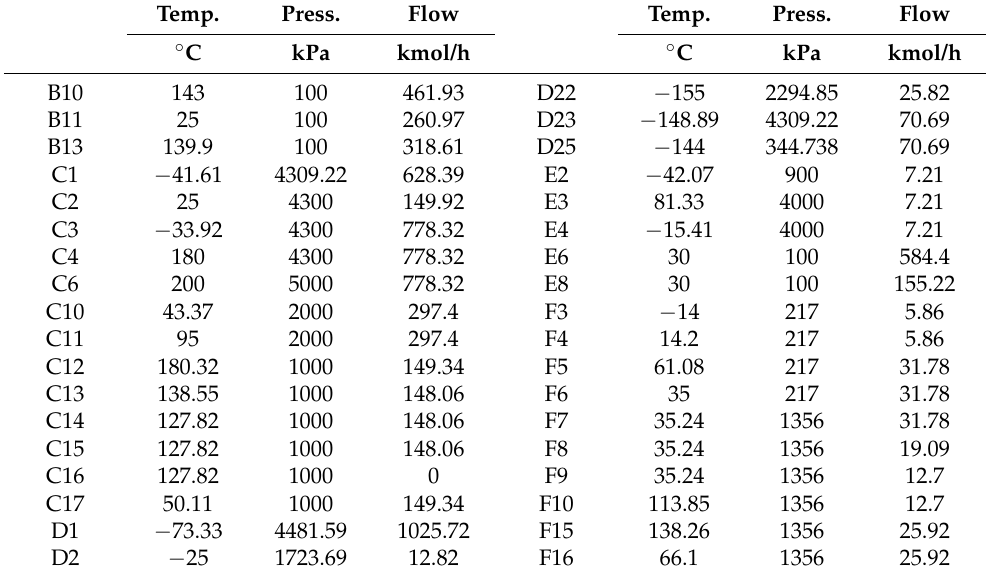
Table A4. Cont. Temp. Press.